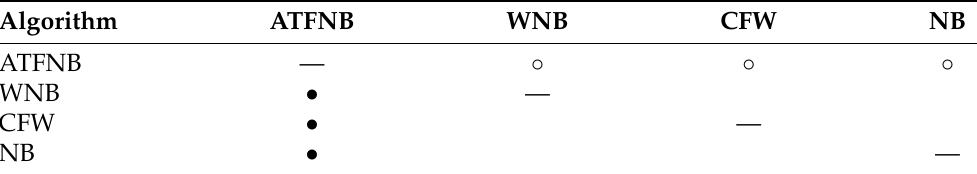
Table 12. Summary of the Wilcoxon test with regard to ATFNB on Flavia